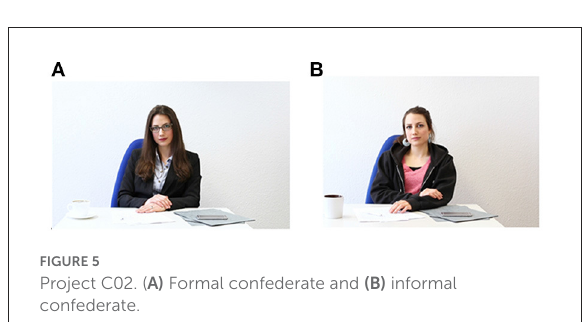
FIGURE5 Project C02. ( A) Formal confederate and (B) informal